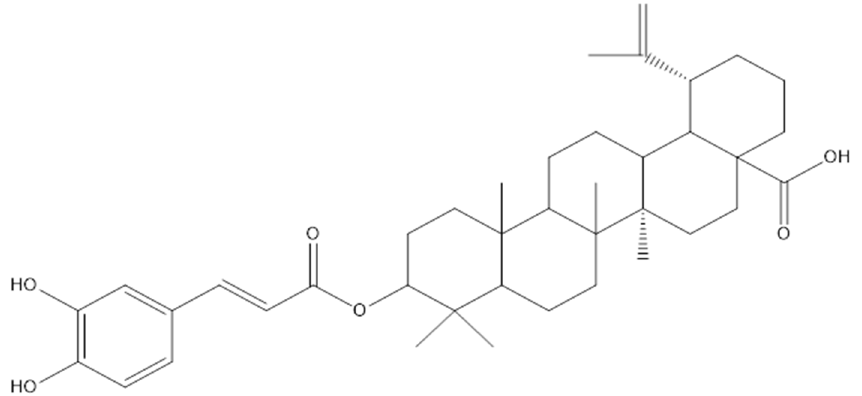
Figure 2. Chemical structure of 3- O-trans -caffeoylbetulinic acid .